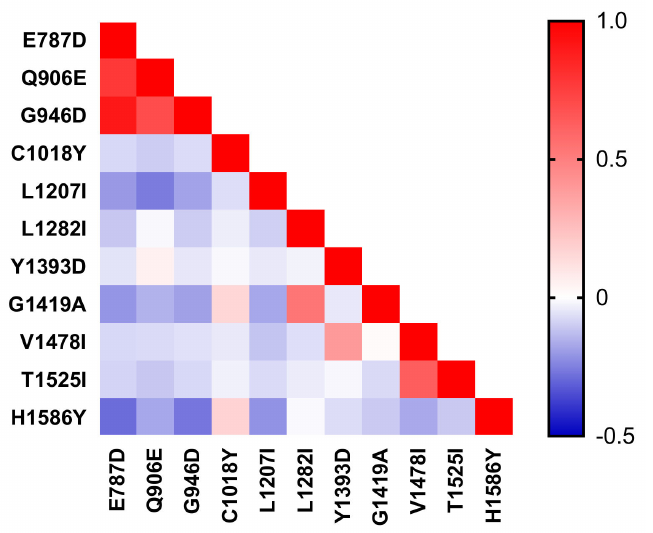
Figure 5. Linkage disequilibrium (LD) plot showing non-random association between nucleotide variants among 166 P. vivax isolates at 11 non-synonymous SNPs. R for each pair of genetic polymor- phisms of pvmrp1